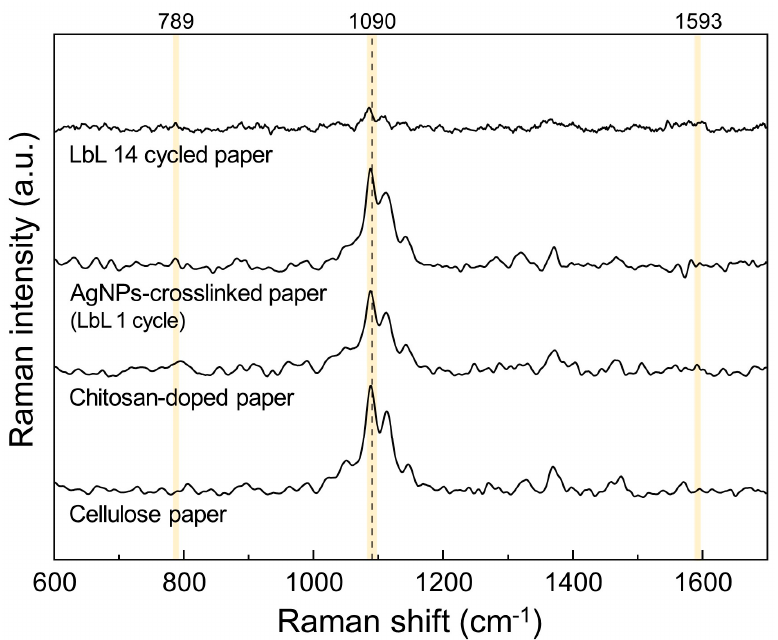
Figure 5. Raman spectra obtained from original cellulose, chitosan-doped, LbL 1-cycle, and LbL 14-cycle substrates, where the yellow bands represent the chemical motifs of the following: glycosidic ring stretching, 1090 cm − 1 ; amine group in chitosan, 1593 cm − 1 ; and silver, 789 cm − 1 .